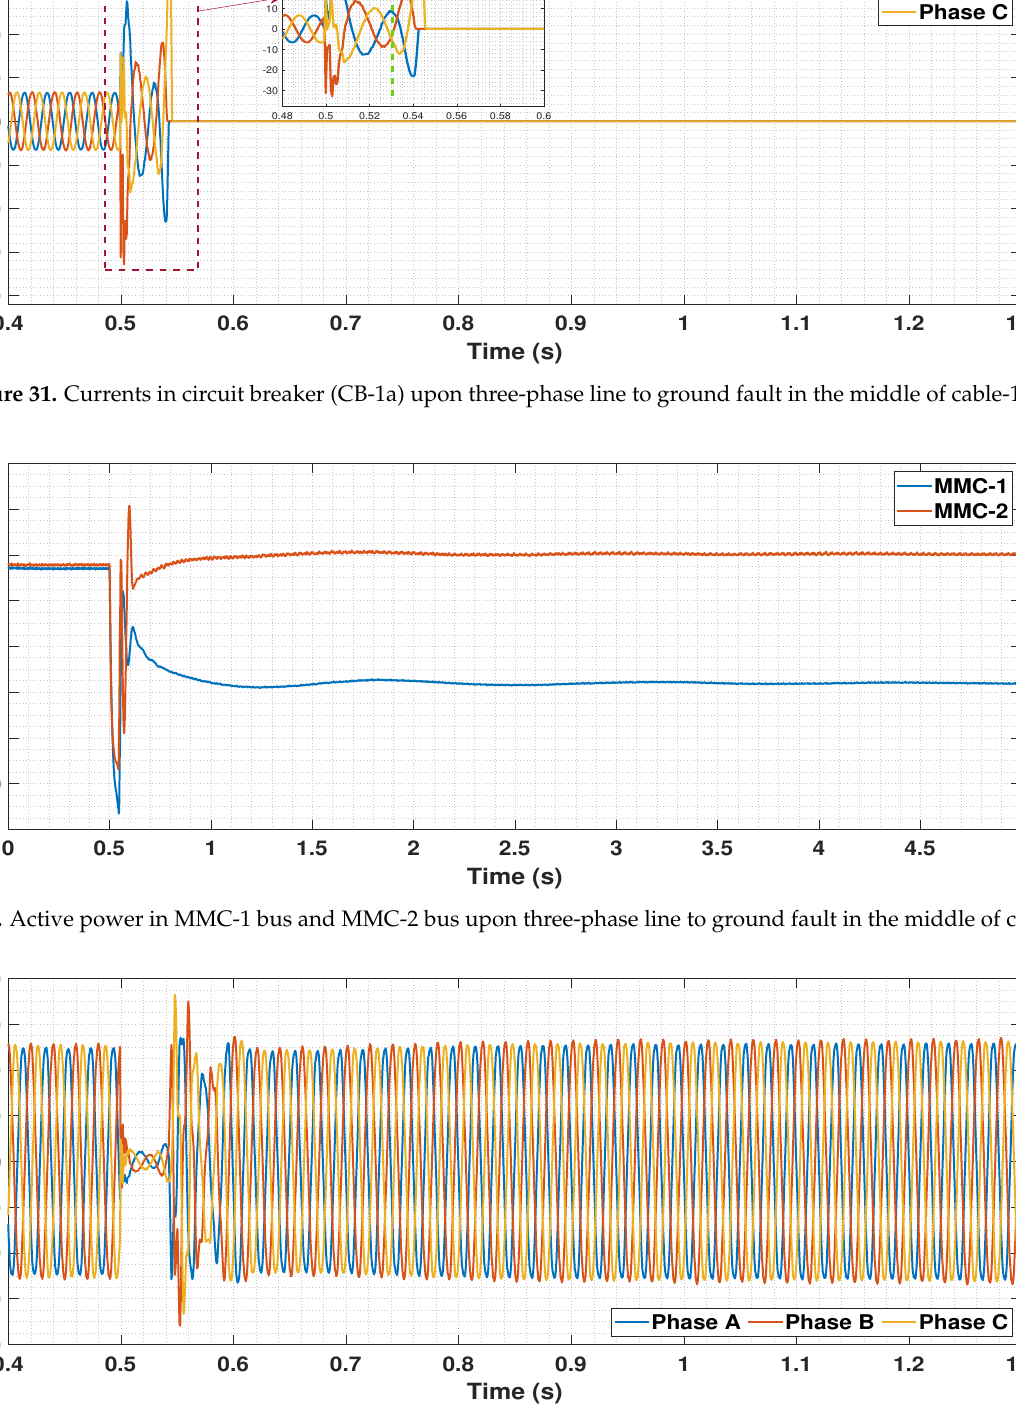
Figure 33. Voltages at MMC bus upon three-phase line to ground fault in the middle of